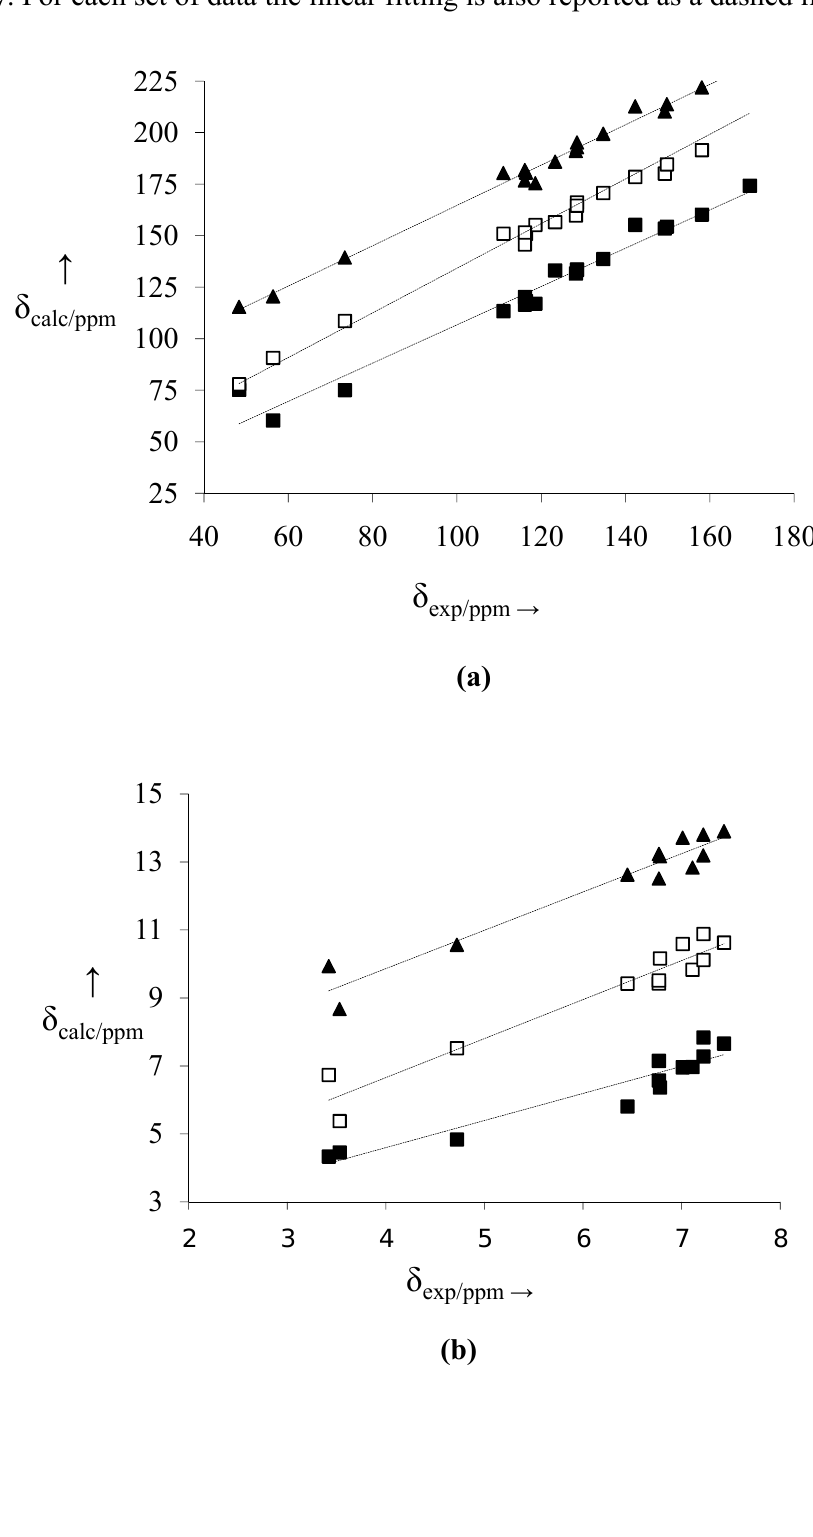
Figure 3. Correlation between experimental and calculated (B3PW91/DGDZVP) chemical shifts of 13 C ( a ) and 1 H ( b ) for structures O ( ■ ), S ( □ ) and N ( ▲ ). NMR data of the structures S and N were displaced from 30 to 60 ppm ( 13 C NMR) and from 3 to 6 ppm ( 1 H NMR), respectively. For each set of data the linear fitting is also reported as a dashed